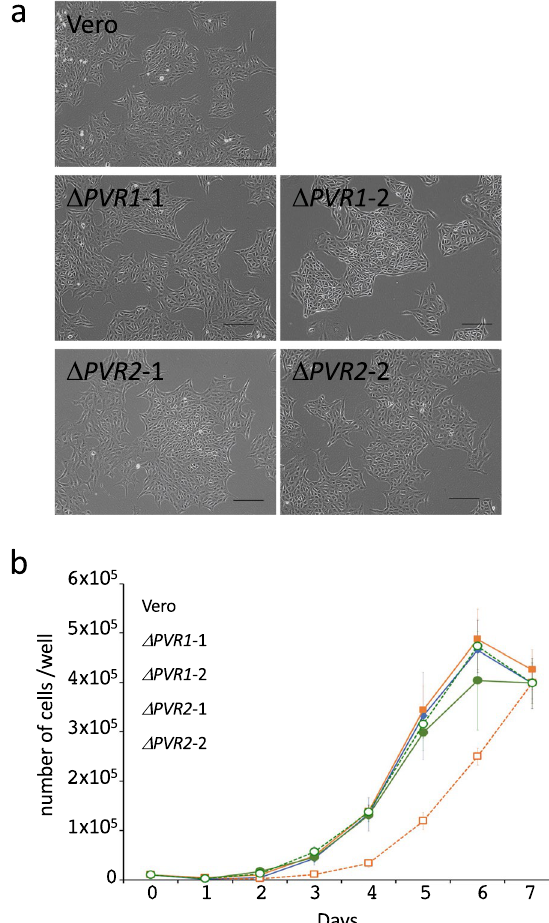
Figure 3. Cell morphology and growth curve of Vero and PVR knockout cell lines. ( a ) Cell morphology of the Vero cell line, two independent PVR1 SKO cell lines (Δ PVR1 -1 and Δ PVR1 -2), and two independent PVR2 SKO cell lines (Δ PVR2 -1 and Δ PVR2 -2; see also Supplementary Fig. 2). Scale bar: 200 µm. ( b ) Cells were seeded into 24-well plates at 1 × 10 4 cells/well and cultured for seven days. Live cells were counted each day and the proliferation curves are shown (means ± Standard Deviation, n =